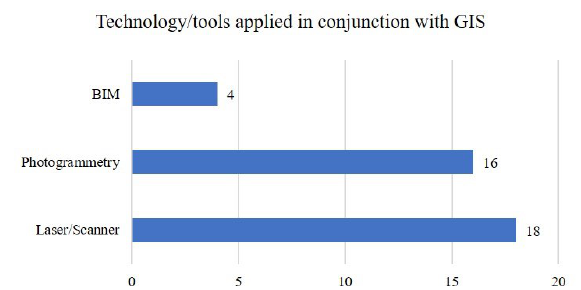
Figure 6: Quantitative analysis of the technologies/tools which were applied in conjunction with GIS in the publications included in the systematic